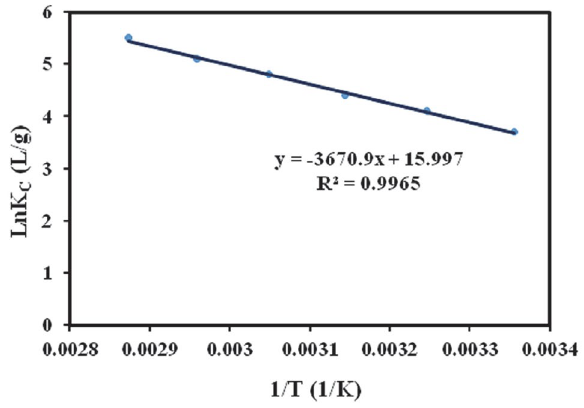
Figure 14. Plots ln K C versus 1/T for adsorption of dyes.